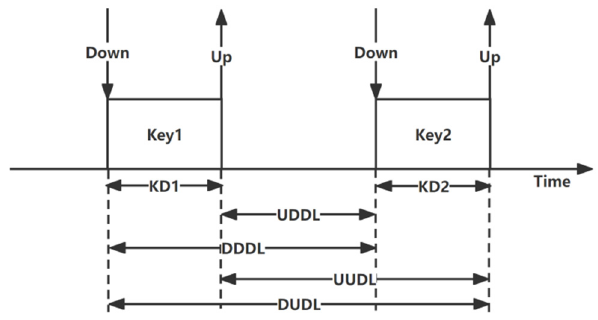
Figure 2. Keystroke dynamics.